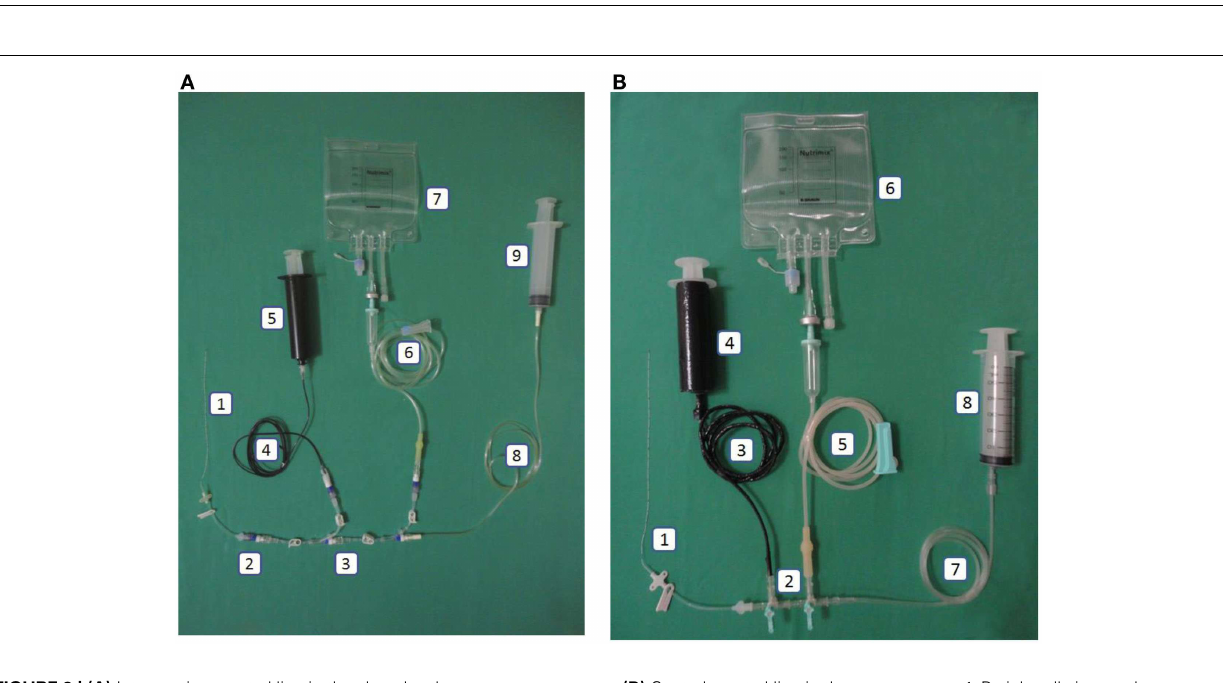
(B) Control: central line in the open system. 1. Peripherally inserted central catheter, 2.Three-way stopcock, 3. Carbon-coated extension tube slip tip, 4. Carbon-coated syringe (lipid), 5. Infusion set slip tip, 6. Total parenteral nutrition bag, 7. Extension tube slip tip, 8. Slip tip